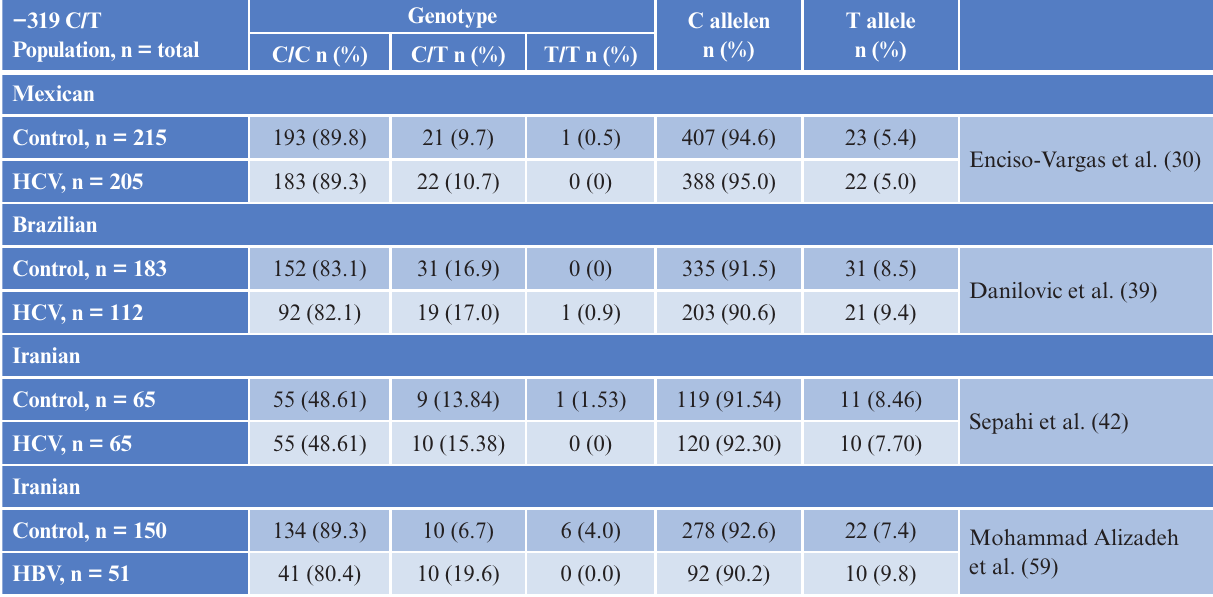
Table 1. Allelic and genotypic frequencies of −319 C/T SNP in HBV/HCV infected patients and control subjects Genotype C allelen −319 C/T Population, n = total